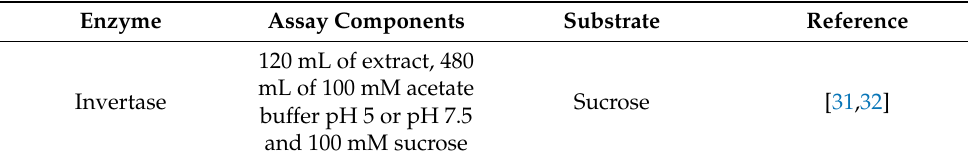
Table 1. Enzyme activity